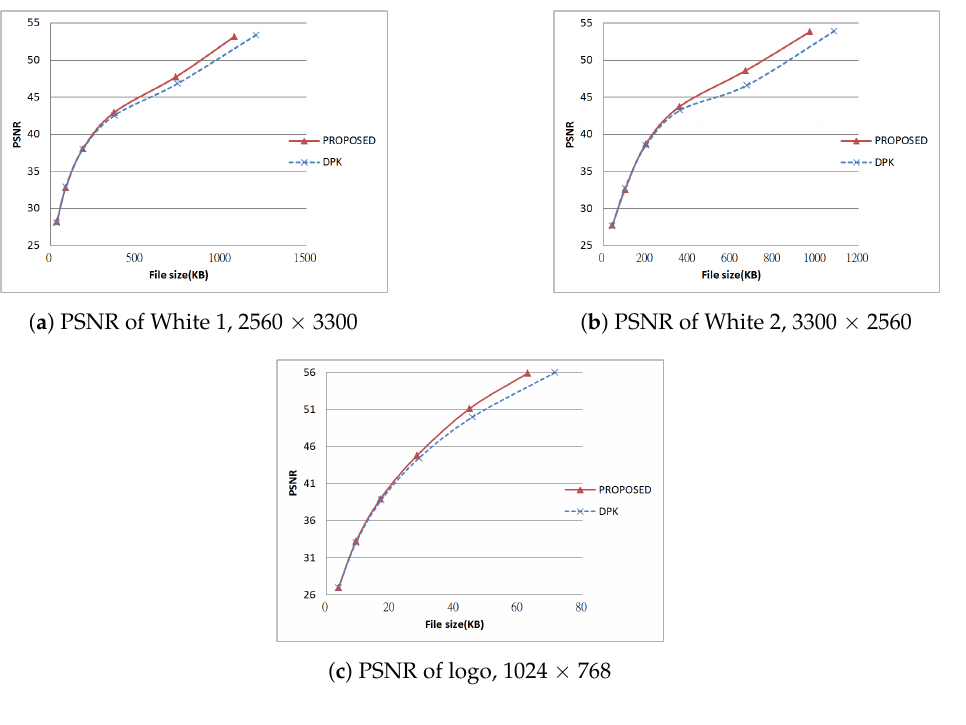
Figure 28. PSNR of test results, Part